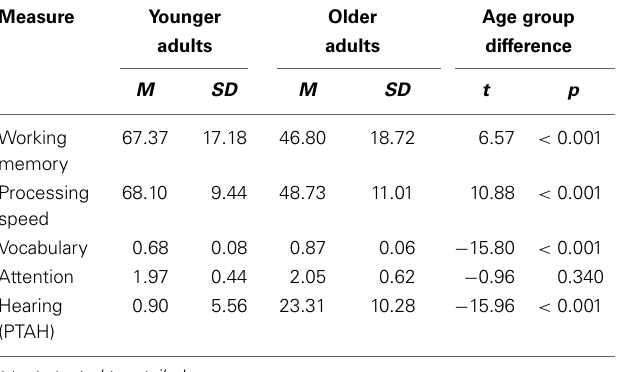
on cognitive, linguistic, and auditory measures.